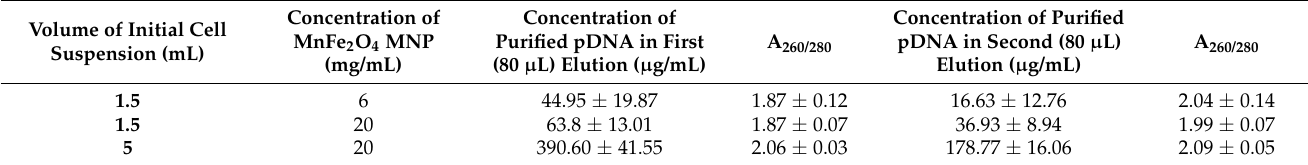
Table 4. DNA concentration of the MnFe 2 O 4 -purified pDNA samples.